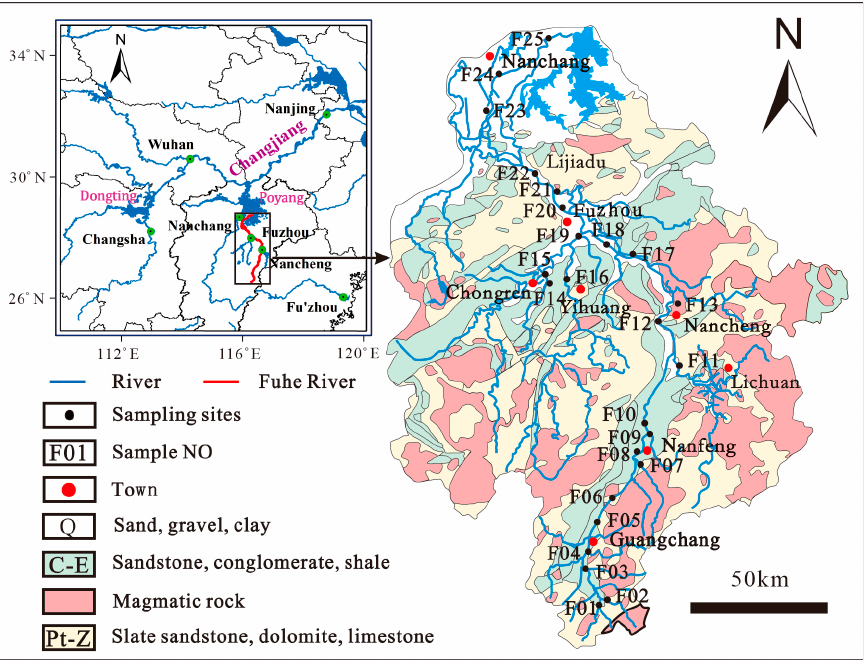
Figure 1. Simplified map showing the lithology and sampling sites in the Fuhe River